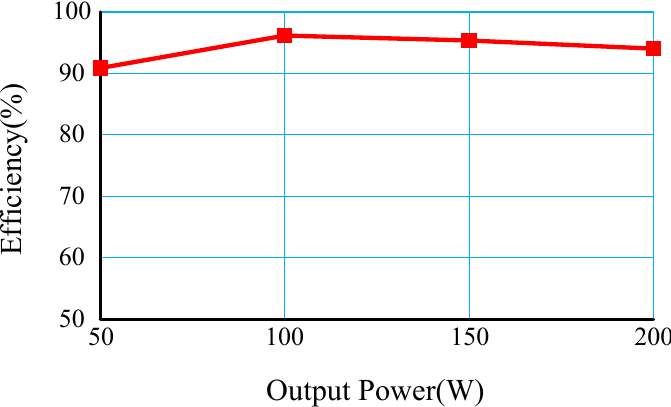
Figure 15. Experimental waveforms v g , M levels: ( a ) 200 W, ( b ) 150 W, ( c ) 100 W, and ( d ) 50 W.